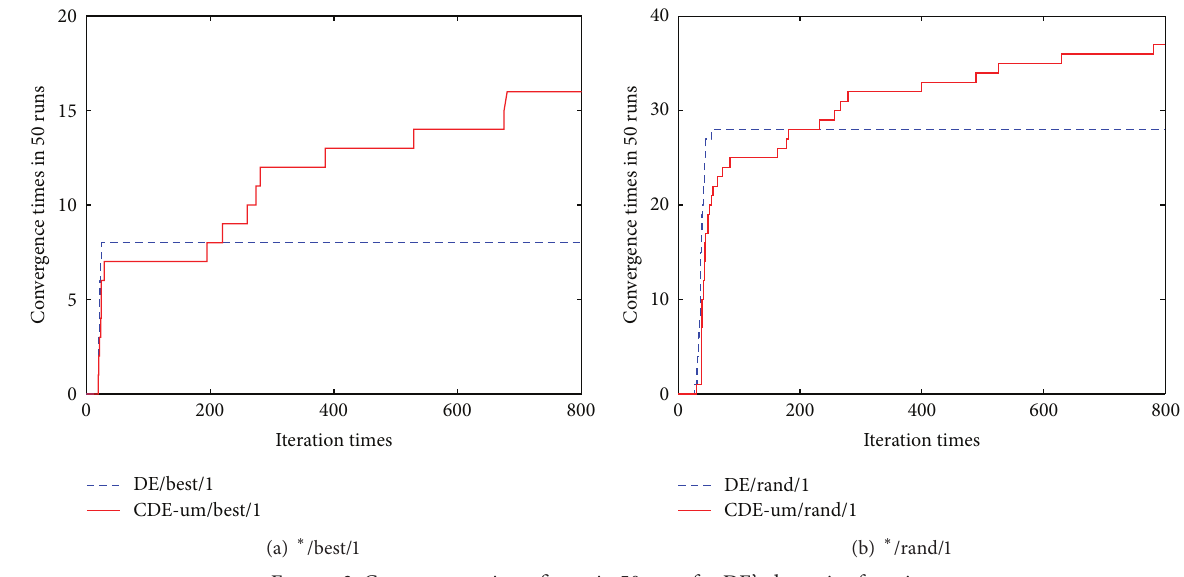
Figure 3: Convergence times figure in 50 runs for DE’s deceptive function.